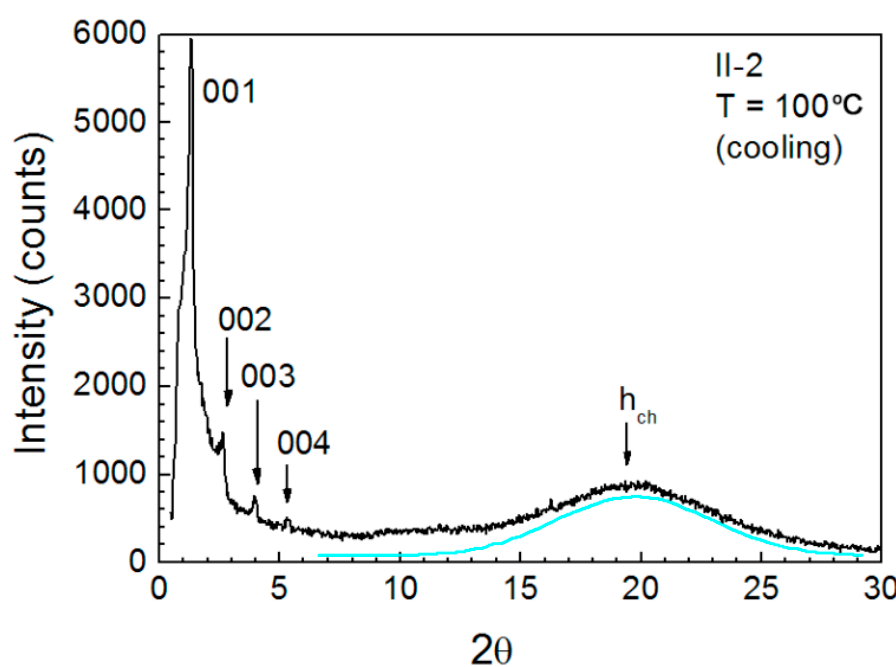
Figure 6. Small-angle X-ray diffraction patterns for polymer II-2 registered on cooling at 100 °